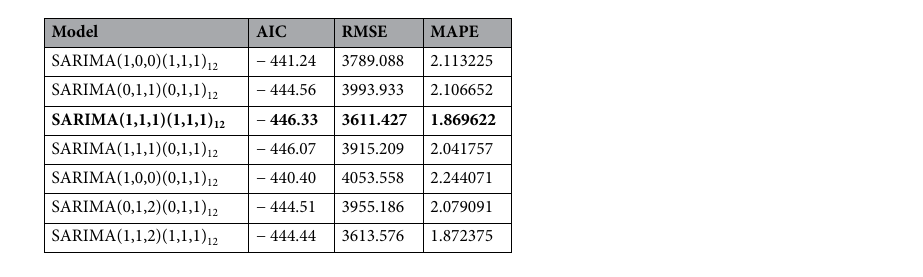
Table 2. Comparison of the performances of different SARIMA model trials. Significant values are in bold.